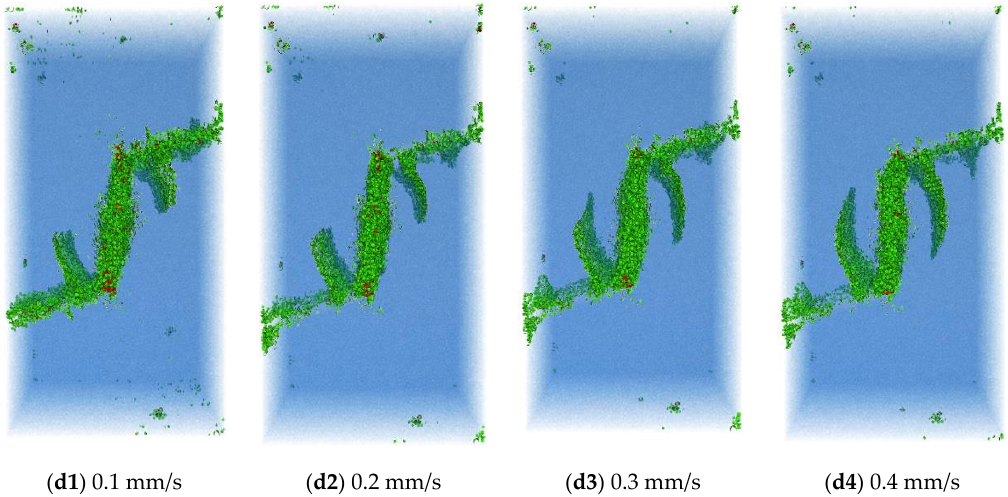
Figure 18. 3-D final failure patterns of different marble specimens, i.e., ( a1–a4 ) Type A, ( b1–b4 ) Type B, ( c1–c4 ) Type C and ( d1–d4 ) Type D, under unloading conditions with various rates.